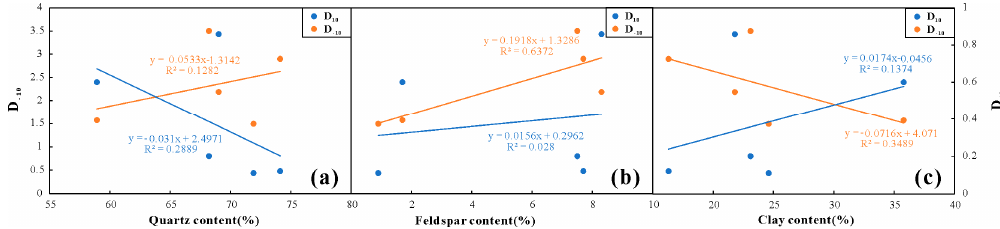
Figure 13. The correlations between mineral compositions and multifractal parameters. ( a ) the correlations between D -10 , D 10 with quartz content; ( b ) the correlations between D -10 , D 10 with feldspar correlations between D − 10 , D 10 with quartz content; ( b ) the correlations between D − 10 , D 10 with content; ( c ) the correlations between D -10 , D 10 with clay content. feldspar content; ( c ) the correlations between D − 10 , D 10 with clay